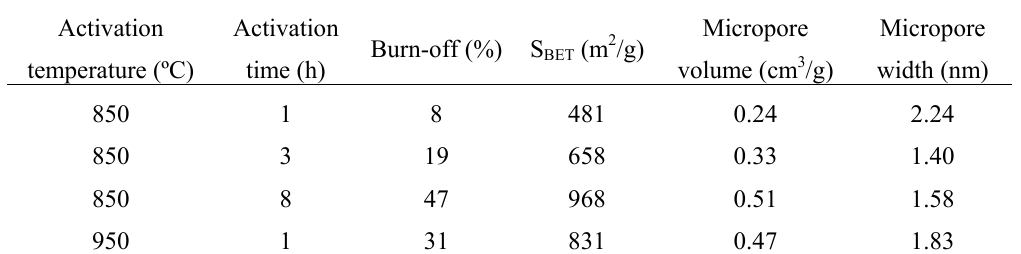
Table 3. Effect of activation time and temperature on the characteristics of the carbon fiber HM. From reference [39], with permission from